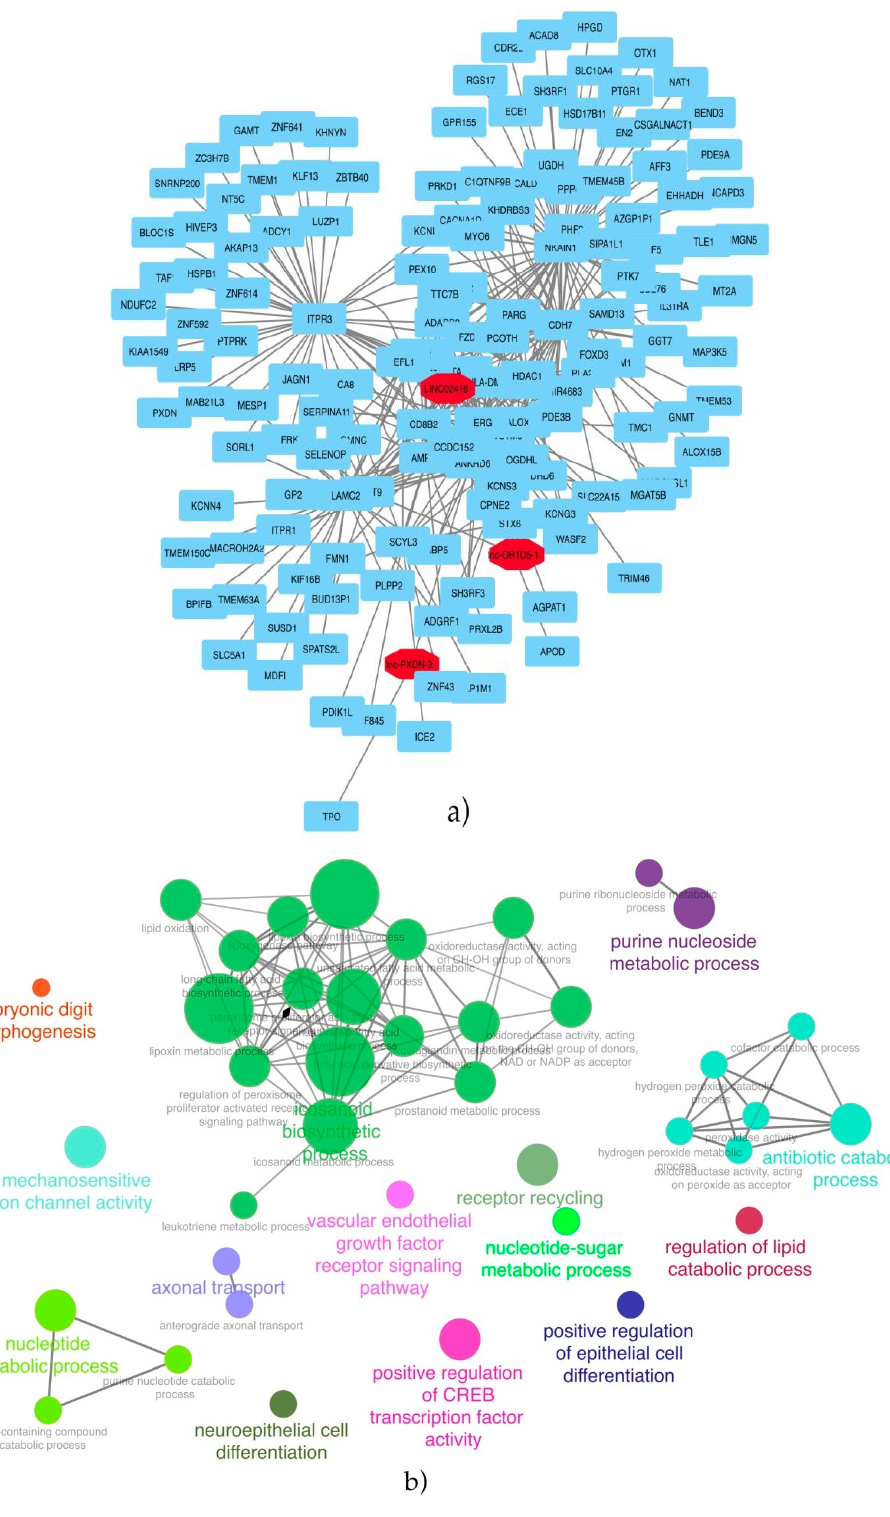
Figure 4. ( a ) Co-expression network, including significant correlation oflncRNAs/coding genes. Red cells indicate lncRNAs showing significant coexpression with mRNAs ( b ). Functional enrichment of the co-expression network. 2.3. PPI Network and Identification of Highly Connected Subnetwork in ERG-Positive Subtype A protein–protein interaction (PPI) network was built up through the STRING database and Cytoscape retrieval engine (Figure 5a). The network was then analyzed through the Molecular Complex Detection (MCODE) algorithm and identified three highly connected subnetworks. The first cluster included the KCNN4, ITPR3, ITPR1 and CACNA1D proteins (Figure 5b), enriched in pathways such as the GnRH (gonadotropin-releasing hormone) signaling pathway, calcium regulation and aldoste- rone synthesis (Table 3).